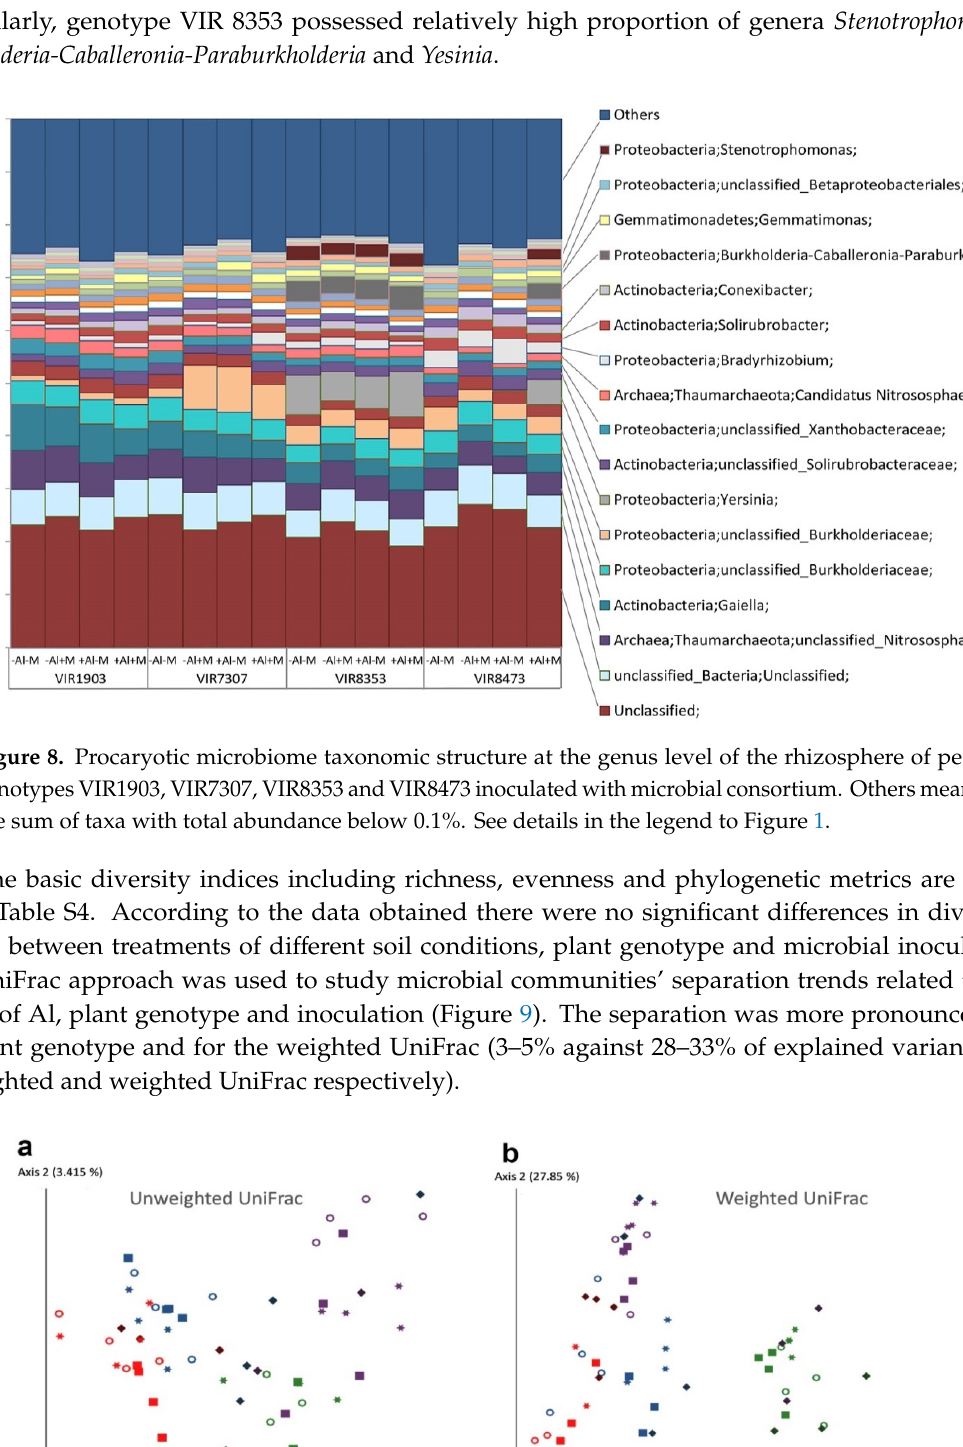
Figure 10. Phylogenetic tree of an “Active” microbiome fraction ( a ) and the size of an “Active” fraction as the percent of the total community affected by the particular factor ( b ). Factors: PLANT - pea genotype, Al – aluminium supplement of soil, M – inoculation with microbial consortium, Al + M – interaction between aluminium supplement of soil and inoculation with microbial consortium. On the right side of the tree the presence (big empty cycle) or the absence (small empty cycle) of each phylotype in an “Active” microbiome fraction for each factor are shown. ND stands for not detected.